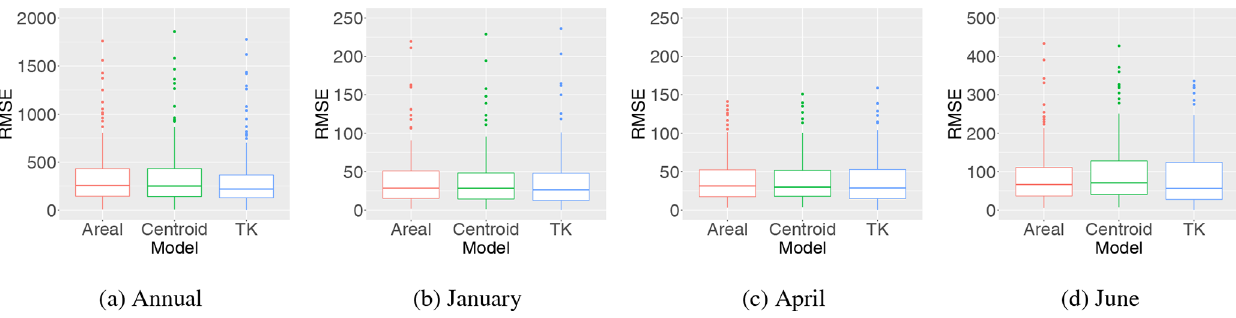
Figure 8. Distribution of RMSE (mmyr − 1 and mmmonth − 1 ) for infill of missing values for all catchments and years (1996–2005) when the target catchments are treated as ungauged (UG) in the cross-validation for the areal, centroid and top-kriging methods. The lower and upper quartiles correspond to the first and third quartiles (the 25th and 75th percentiles), and the whiskers extend from the quartiles no further than 1 . 5 · IQR, where IQR is the distance between the first and third quartiles. The same applies for all boxplots presented in this